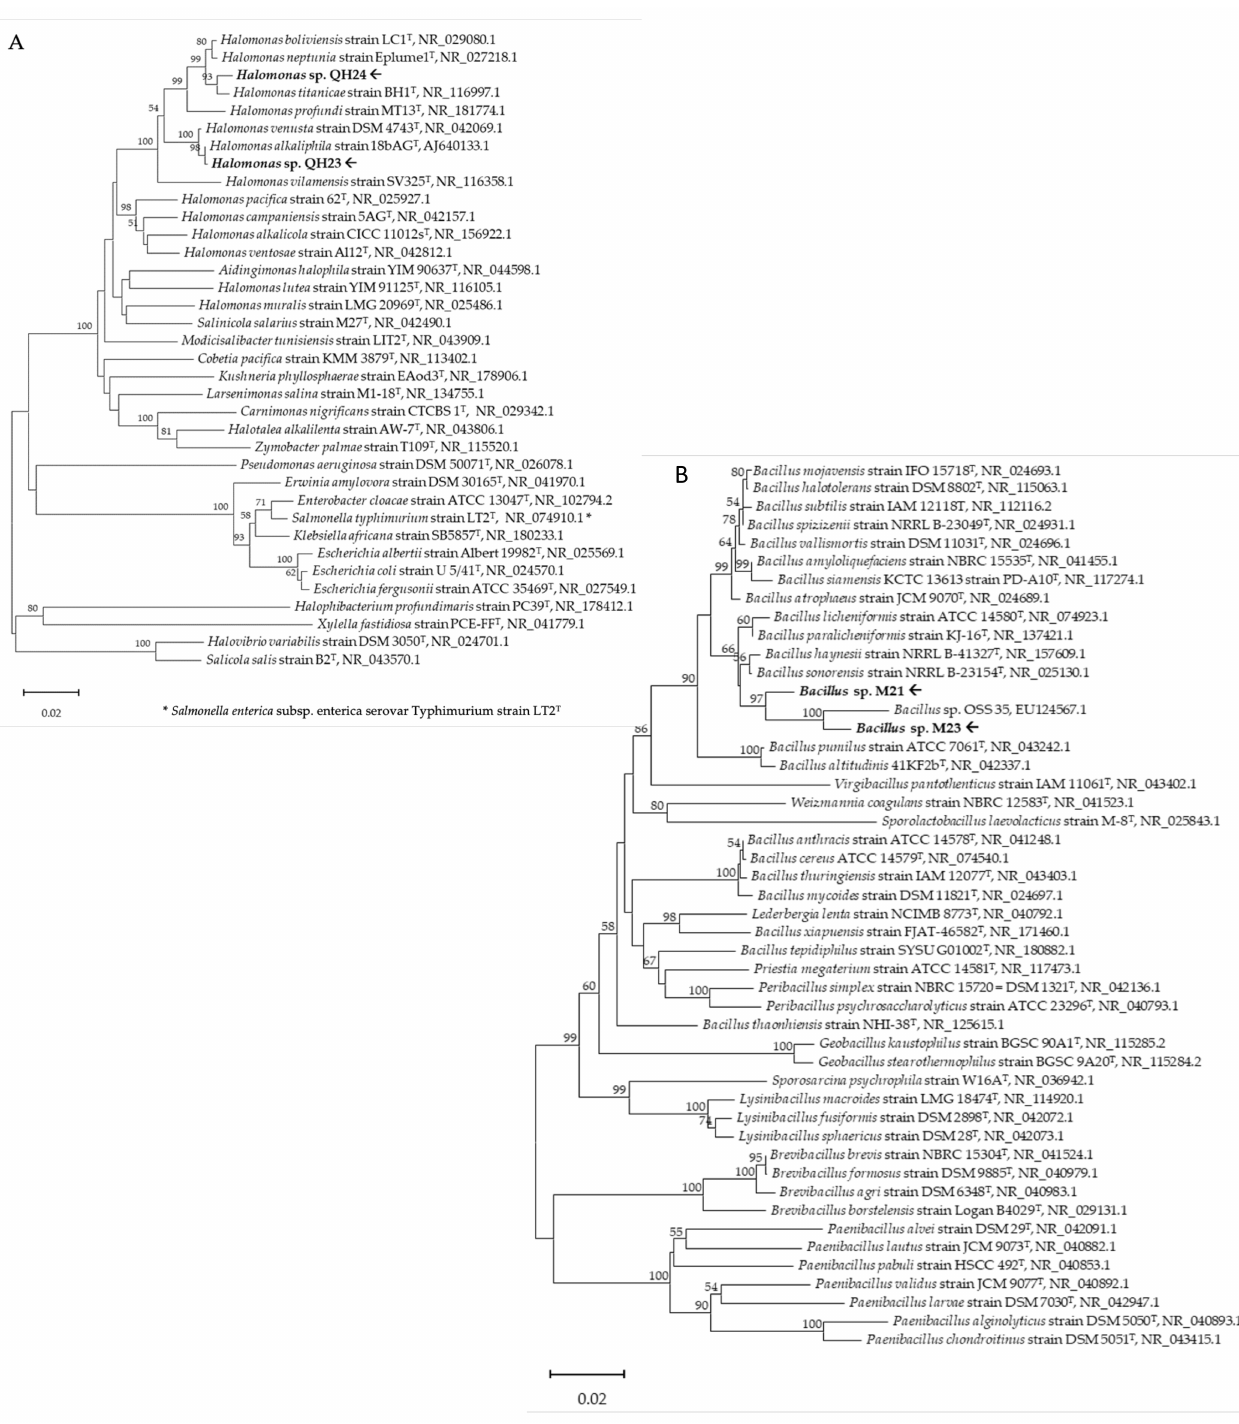
Figure 1. Taxonomical positions of the isolate strains based on the 16S rDNA sequence. Phylogenetic trees, obtained by the neighbor-joining method, show the relationships of Halomonas sp. QH23 and Halomonas sp. QH24 ( A ), and of Bacillus sp. M23 and Bacillus sp. M21 ( B ), with the related bacterial species. Bootstrap values ≥ 50 are reported at the branch points. T indicates the type strains. The access number of the relative strains is